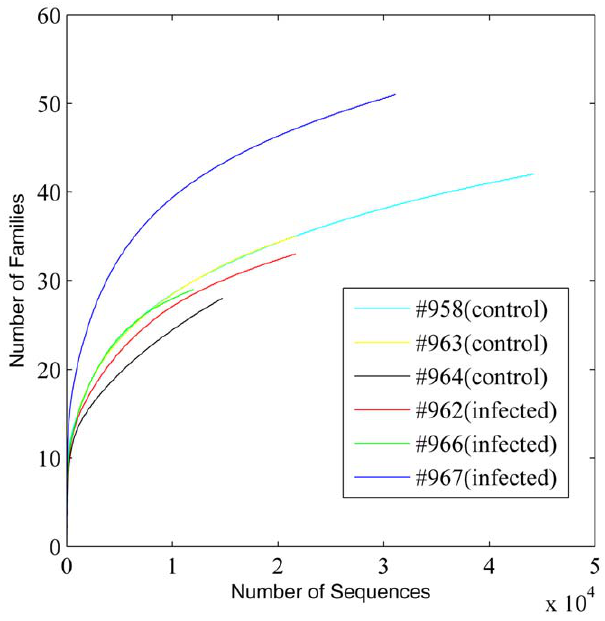
Figure 1. Family-level rarefaction curves of control and infected animals based on the 16S rDNA sequences analyzed using RDP Classifier with a confidence threshold of 80%.